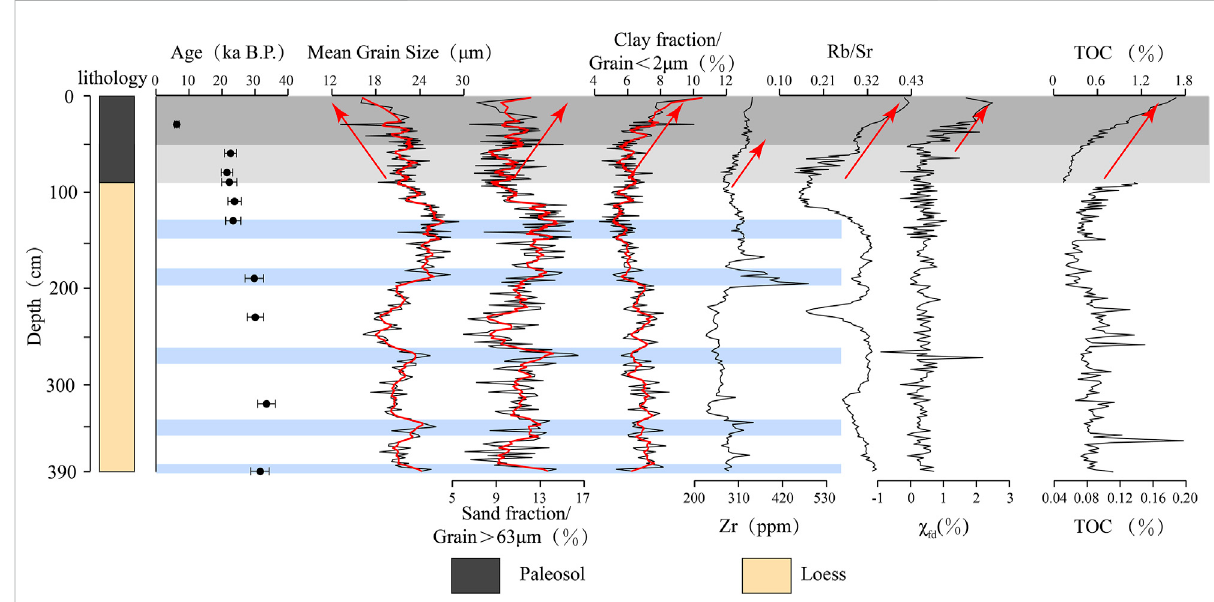
FIGURE 2 Grainsizeandmulti-climateproxiesresultoftheJRTsection.Theloess-paleosolsequenceisdeterminedbyacombinationof fi eldobservation andclimateproxies;Thetwograyboxesindicatethesedimentswithsoil-formingactionandvegetationdevelopment;theredarrowmarksthetrend ofeachindicatorinthepaleosol;theredlineisthesmoothedcurveobtainedbytheadjacencyaveragingmethod;theblueboxcontainsthe fi vehigh relatively high values of MGZ and sand